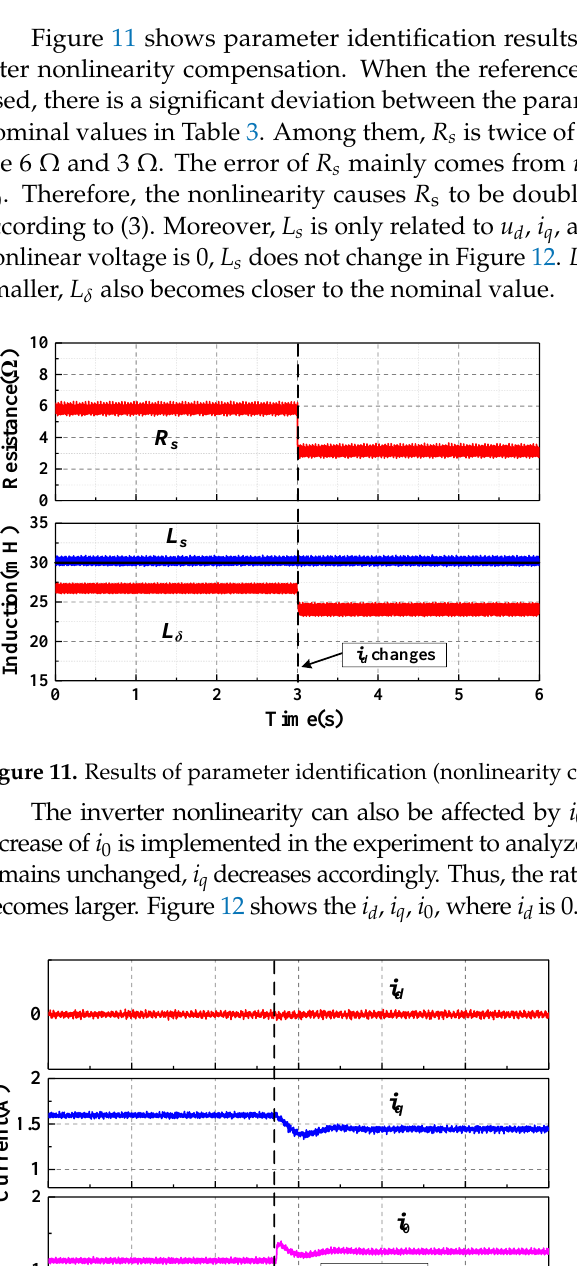
Figure 12. Current waveforms ( i 0 changes). Figure 13 shows the calculated nonlinear voltage and its equivalent value during i 0 changes. The zoomed waveforms after i 0 changes are also shown in Figure 13. After i 0 increases, V 0 err increases, while i q and V qerr decrease. Since i d remains 0, V derr does not change. Figure 13 also shows the result of the nonlinear voltage passed through the low-pass filter. The filtered waveform is consistent with the calculated equivalent nonlinear voltage, which also verifies the accuracy of the proposed nonlinear voltage calculation method. However, the low-pass filter cannot be used in the nonlinear voltage calculation because of its computation burden and slow response